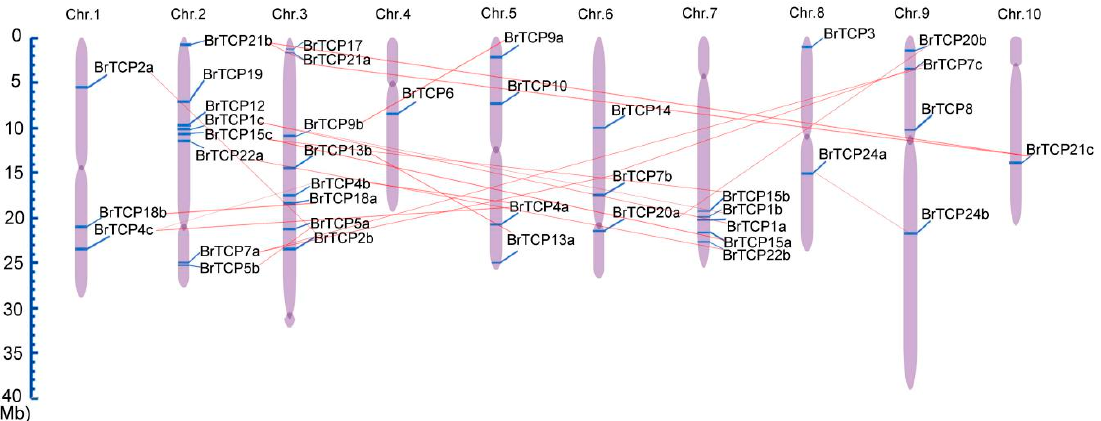
Figure 1. The chromosomal location of TCP genes from Chinese cabbage. The scale represents 40 Mb chromosomal distance. The chromosome numbers are labeled on the top of them. The duplicated gene are connected with red lines.